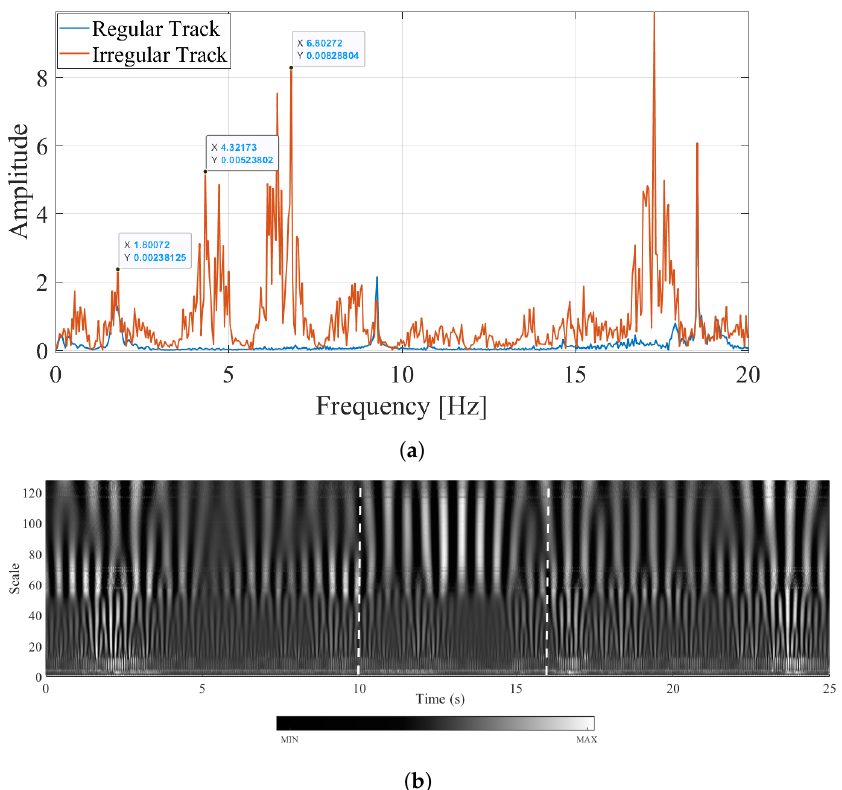
Figure 14. Frequency content of the accelerations recorded on the bogie for a speed of 20 km/h for the track irregularity profile A ( a ) Fourier Amplitude Spectrum ( b ) Wavelet Coefficient